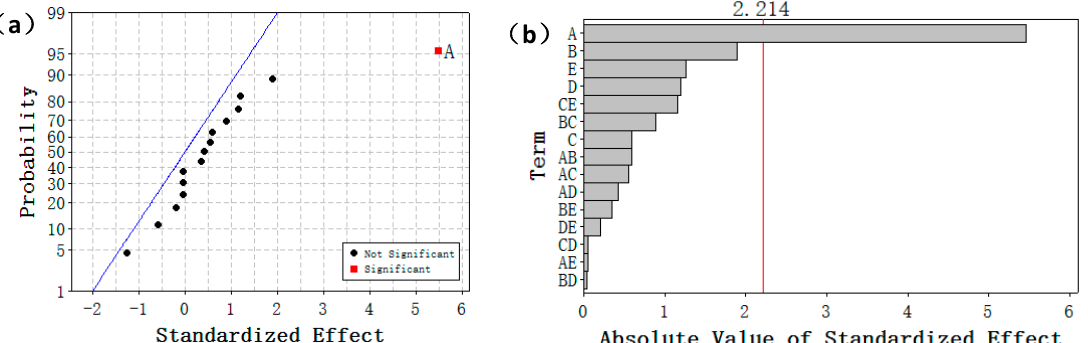
Figure 8. ( a ) Normal plot of the standardized effects; ( b ) Pareto chart of standardized effects for adsorption capacity (qe): (A) pH, (B) temperature, (C) time, (D) Cd(II) concentration, (E) NaCl.